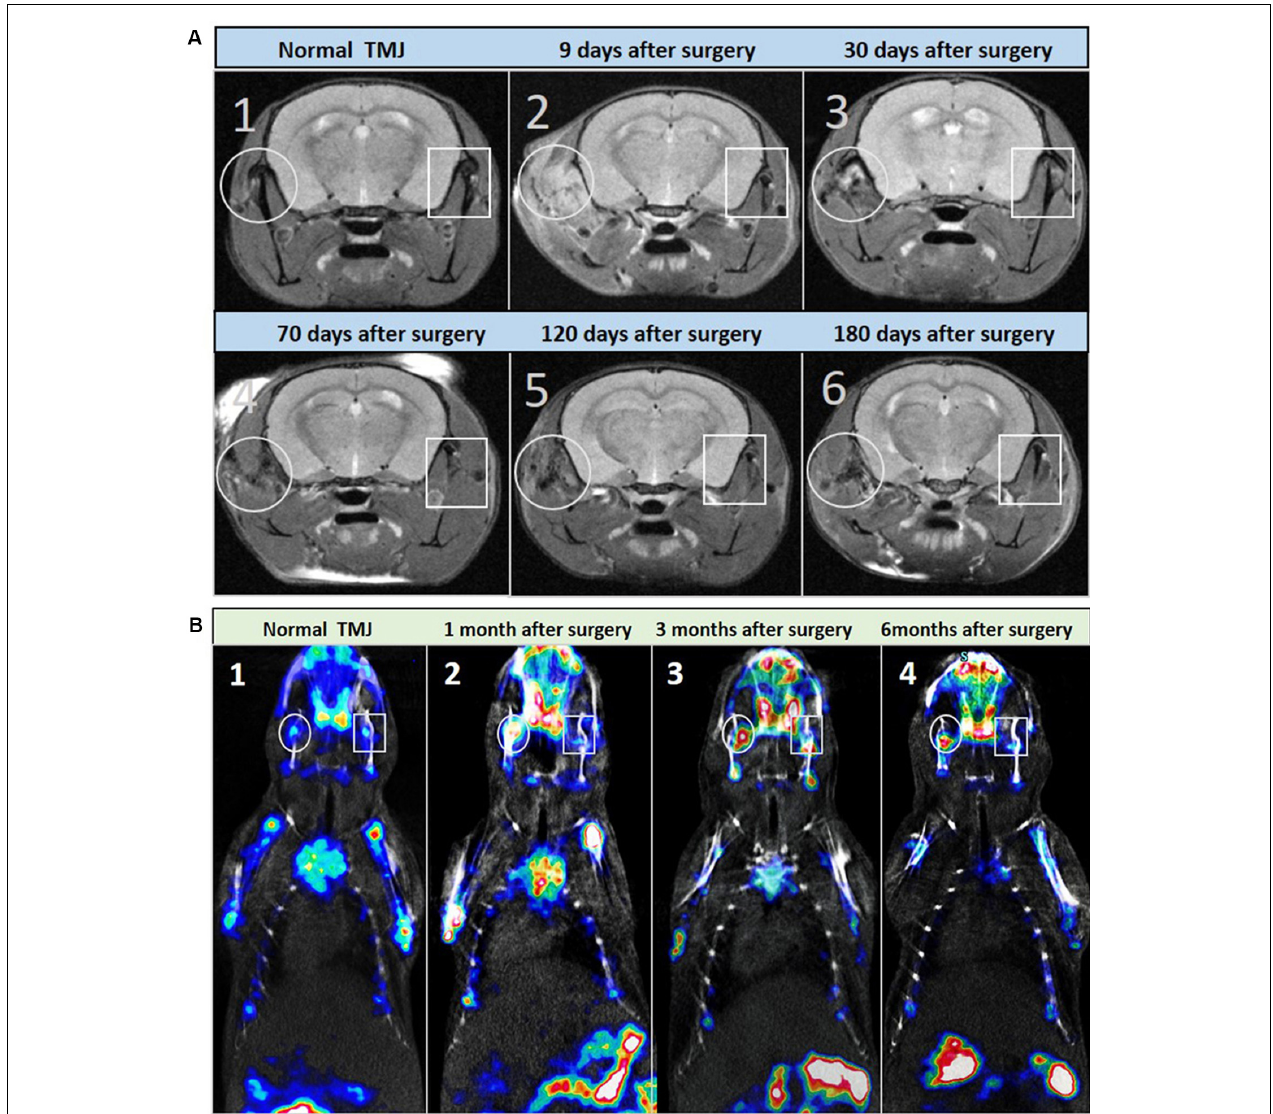
FIGURE 3 | Micro-MRI and micro-SPECT examination of the first animal model (the articular disc and half condylar cartilage were removed) during the development of THO-TMJ. (A) Micro-MRI examination results showed a strong T2 signal around the TMJ on the injured side, which was gradually reduced and replaced by a weak signal of heterotopic ossification compared with the normal side of the TMJ in the animal model (A2–A6) and the TMJ in the normal control mice (A1) over time. (B) Micro-SPECT examination results showed no obvious difference in bone metabolism between the two sides of the TMJ in normal control mice (B1) , but it showed strong bone metabolism (red color) in the injured TMJ region compared with that in the normal side at different time points after surgery (B2–B4) ; white circle: left, injured TMJ; white rectangle: right, normal